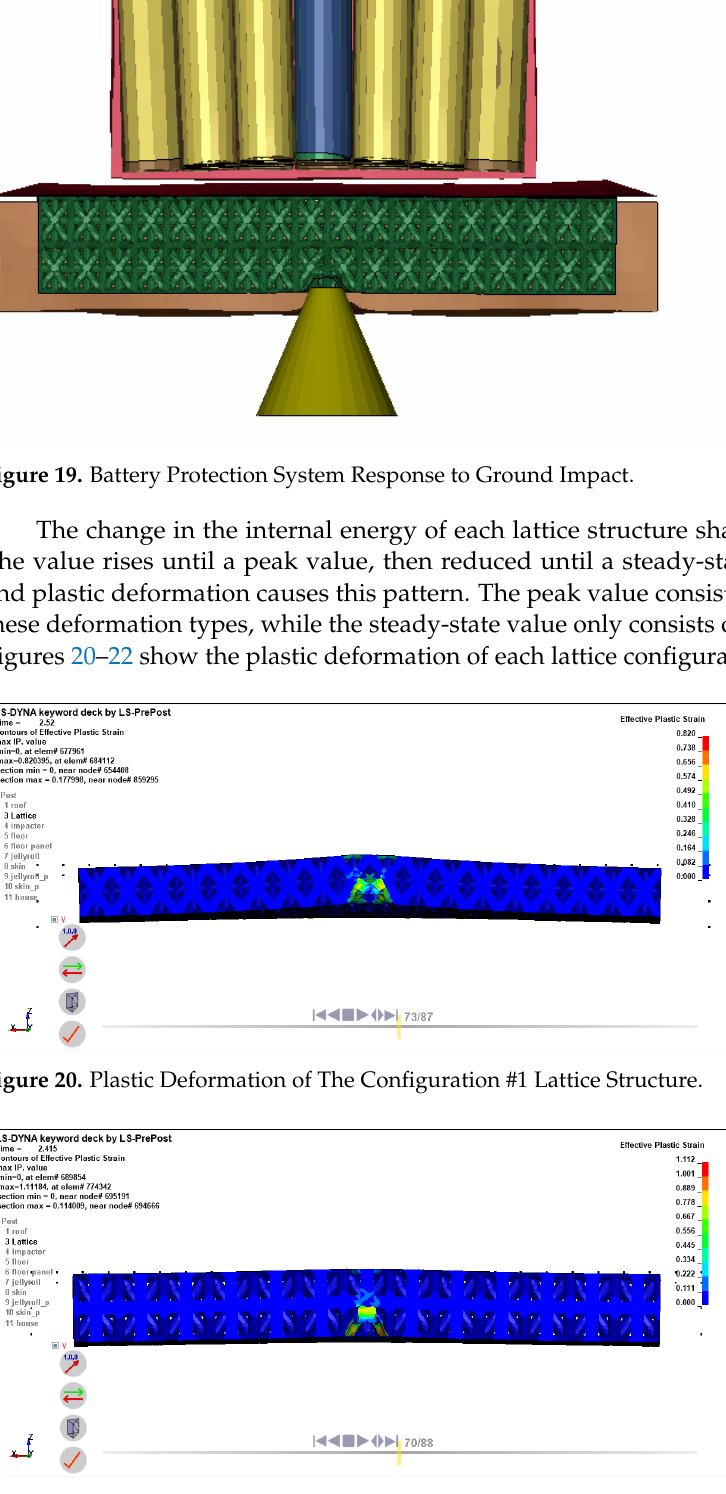
Figure 21. Plastic Deformation of The Configuration #2 Lattice